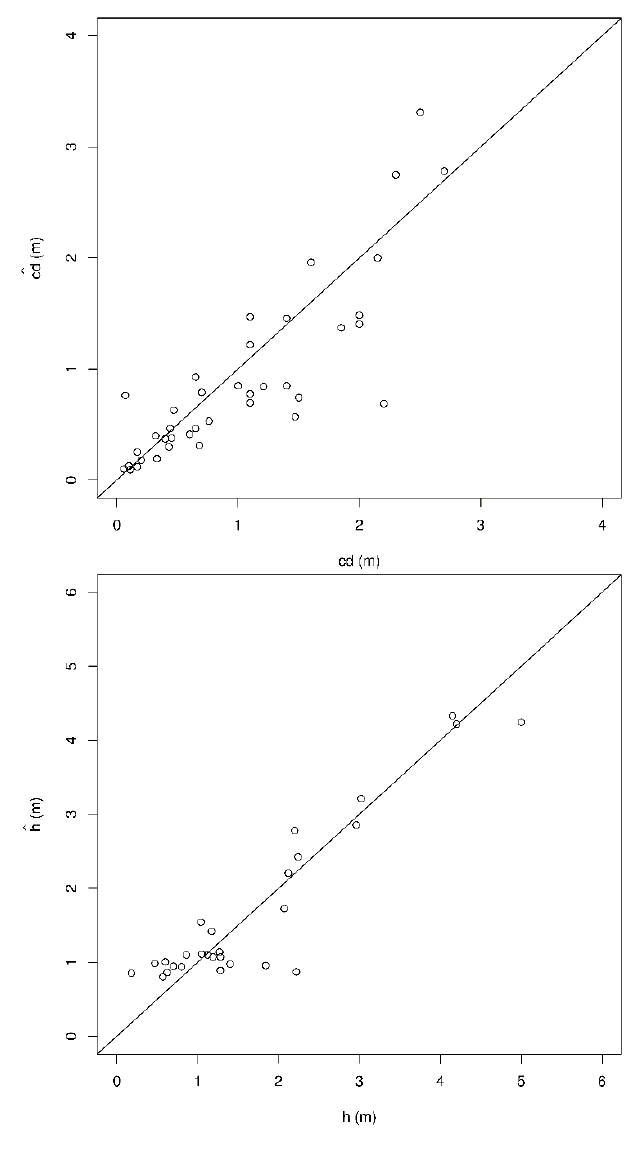
Figure 5. Observed versus predicted values for the two linear models: Height–crown diameter model given in Equation (1) ( top ), and ALS height–field height given in Equation (2) ( bottom ).